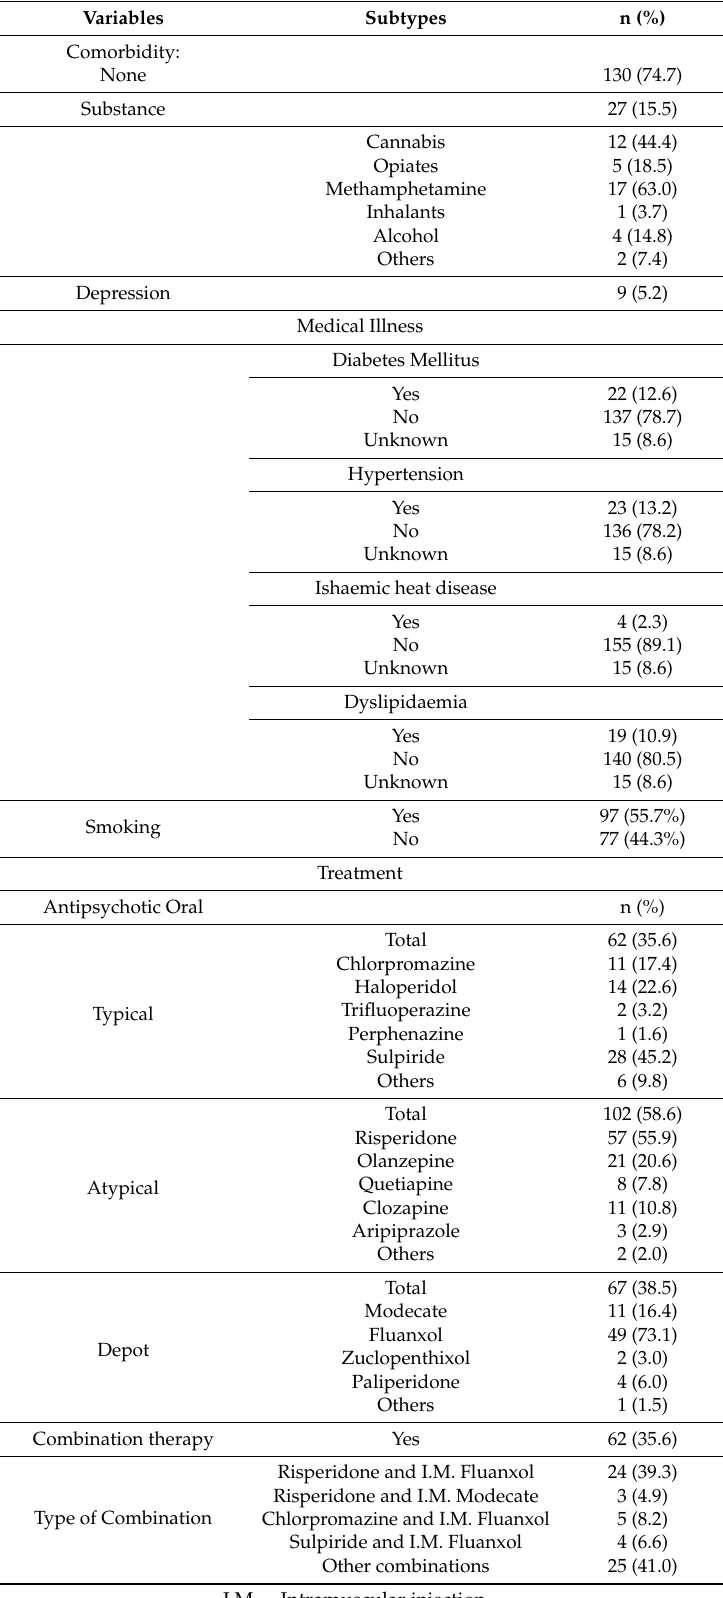
Table 2. Clinical characteristics of the study